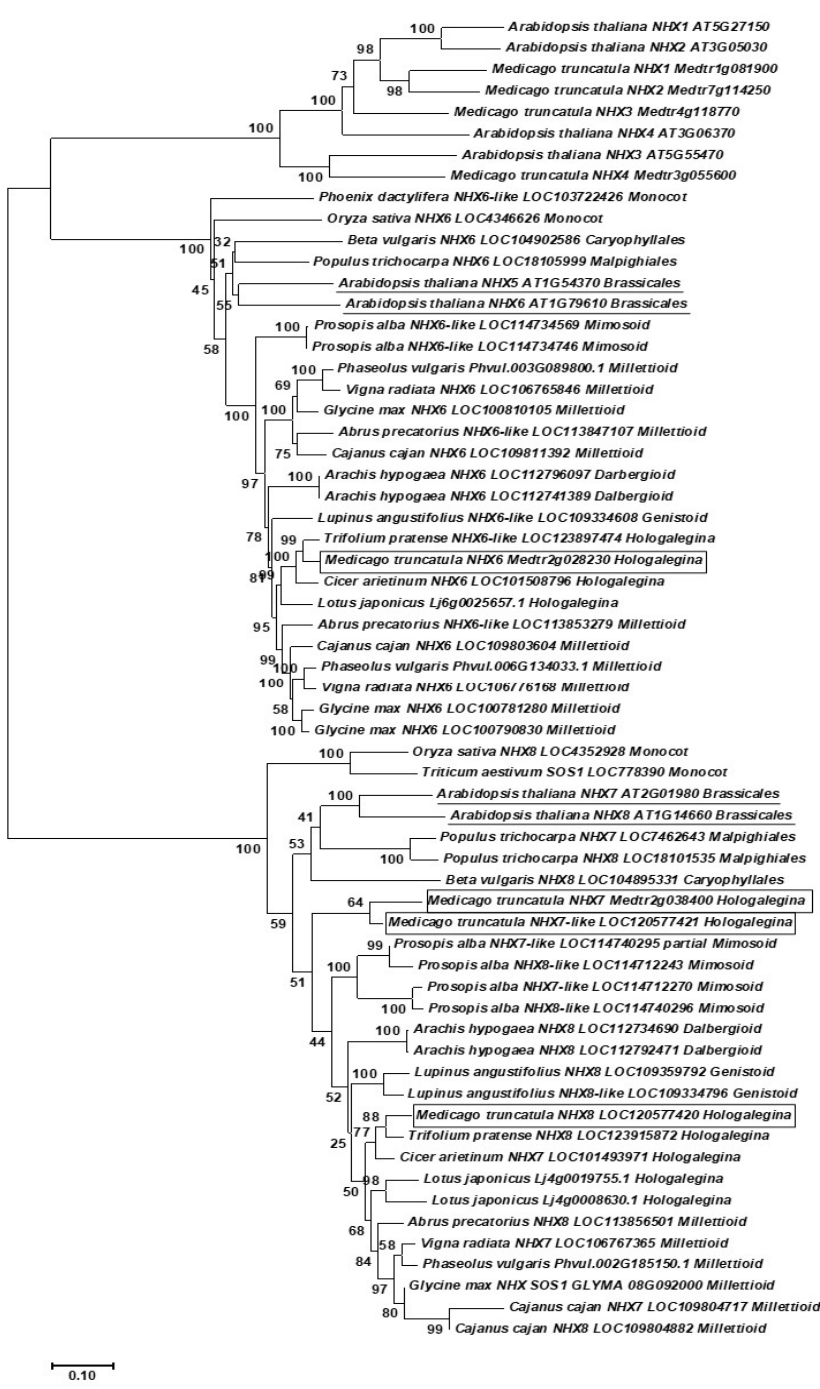
Figure 6. Evolutionary analysis of NHX genes in M. truncatula , other legume species, and Arabidopsis thaliana . Other plant species where NHX6-7-8 genes have been characterized also have been included. The M. truncatula NHX6-7-8 homologous genes are contained in boxes. The corresponding A. thaliana homologs are underlined. Bootstrap values are shown next to the branches (1000 pseudoreplicates). The tree is drawn to scale, with branch lengths measured in the number of substitutions per site. For each gene, the gene name is indicated. Plant orders (for non-legume species) and legume clades are also